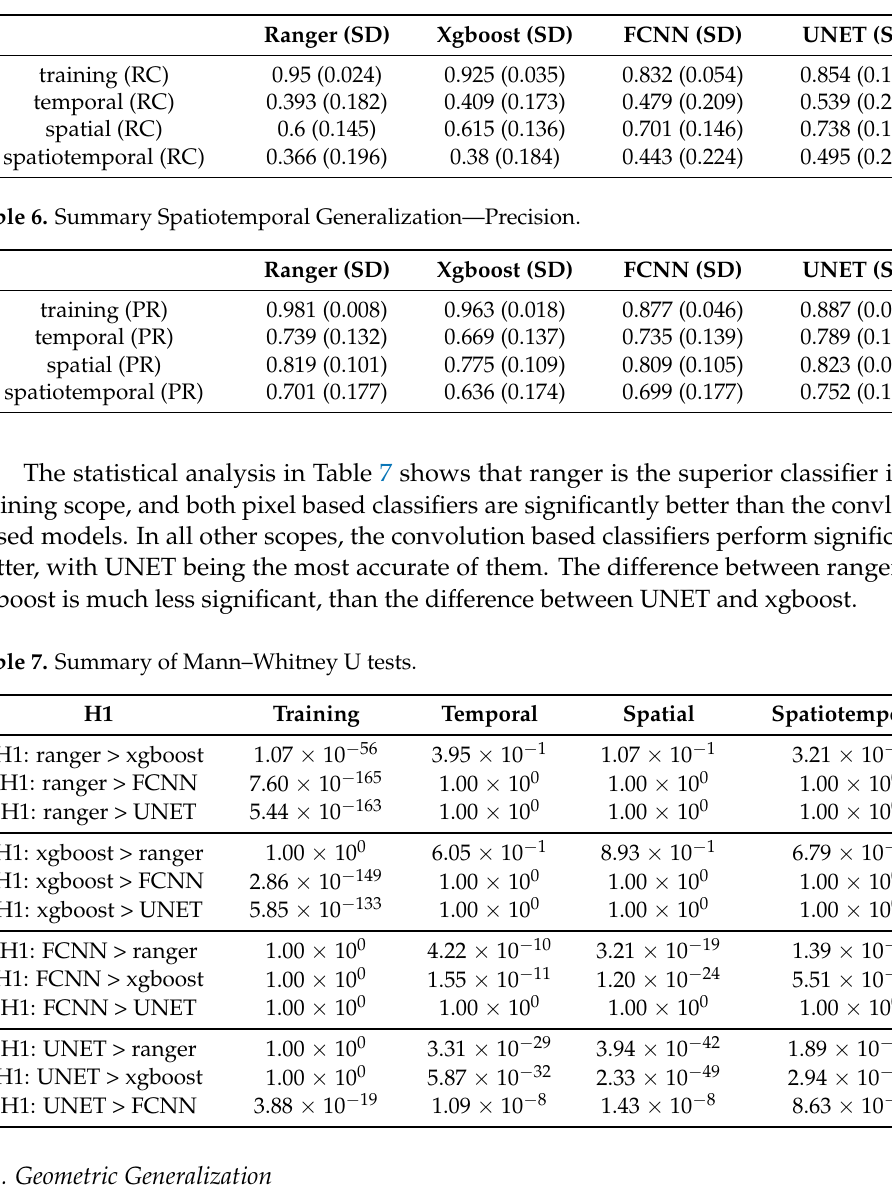
Table 5. Summary Spatiotemporal Generalization—Recall.